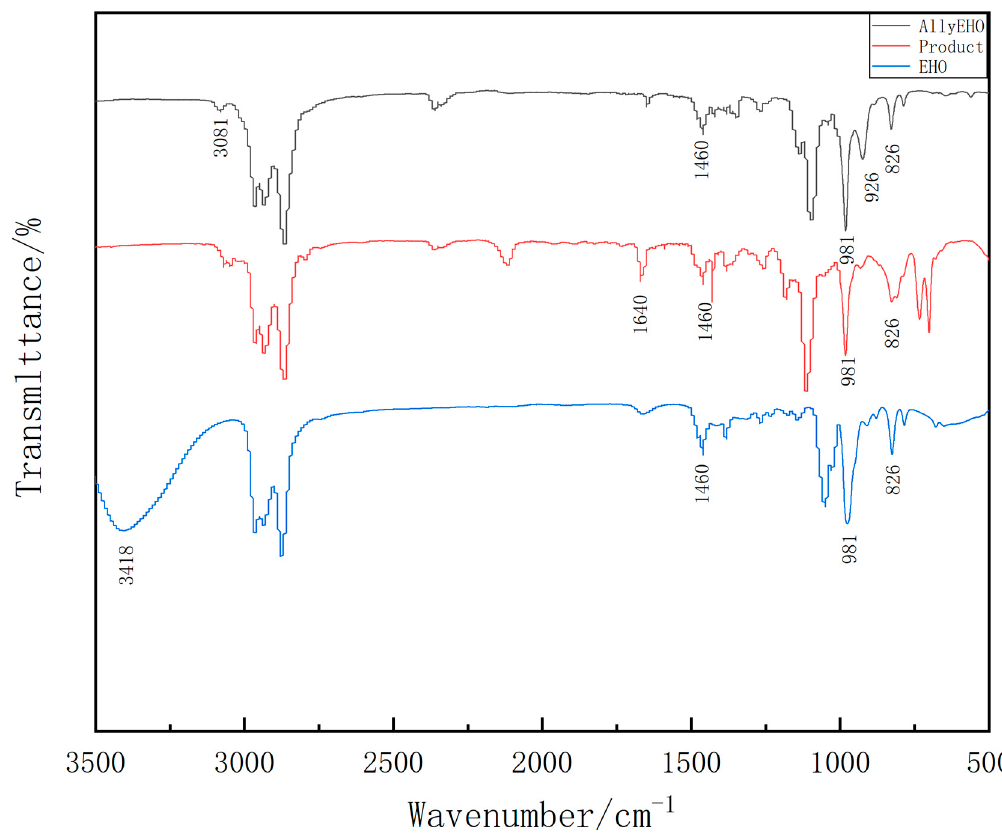
Figure 4. Infrared spectra of EHO, AllylEHO and bis[(3-ethyl-3-methoxyoxetane)propyl]diphenylsilane.